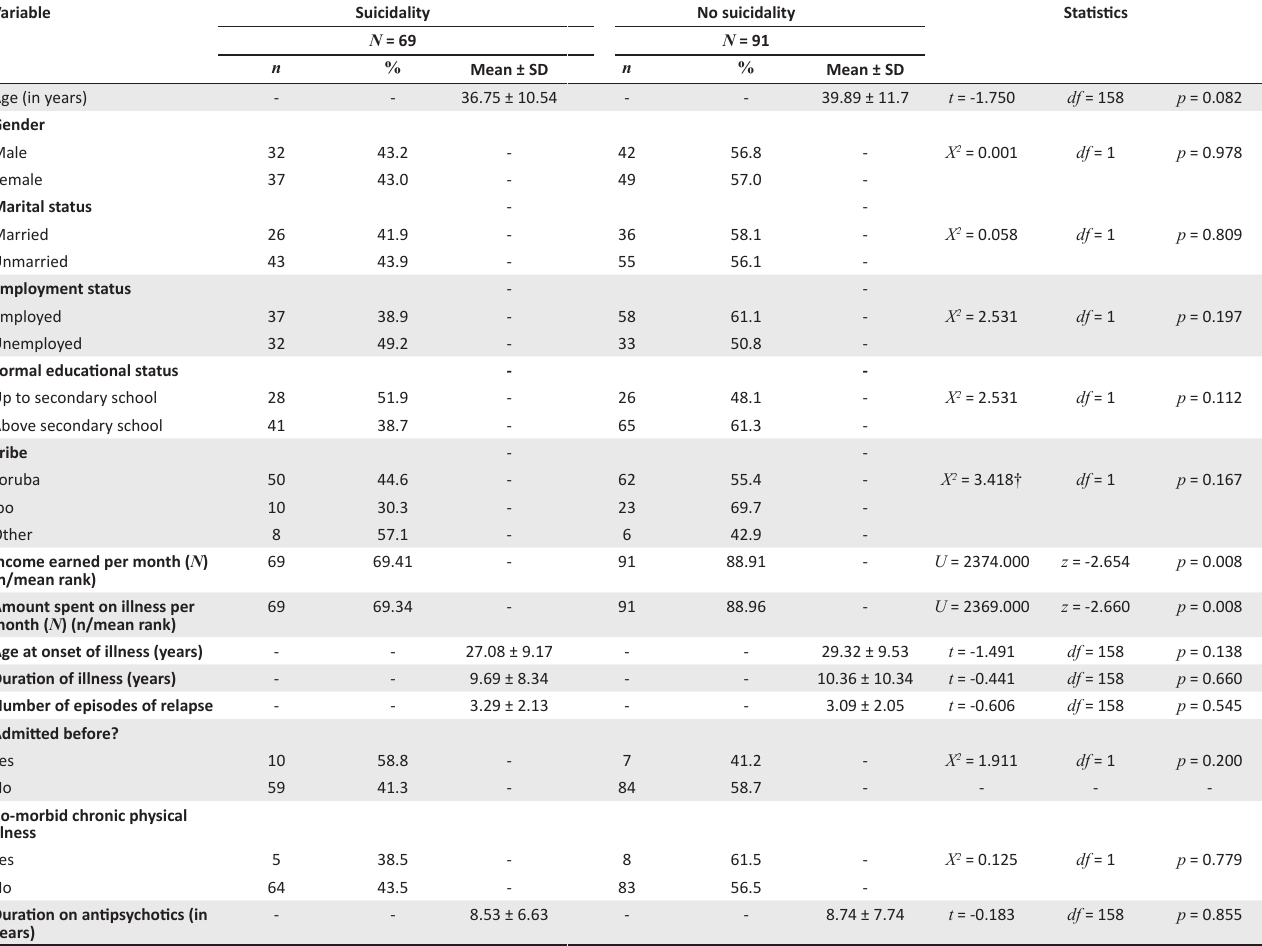
TABLE 3: Relationship between socio-demographic and clinical attributes of participants and suicidality ( n =